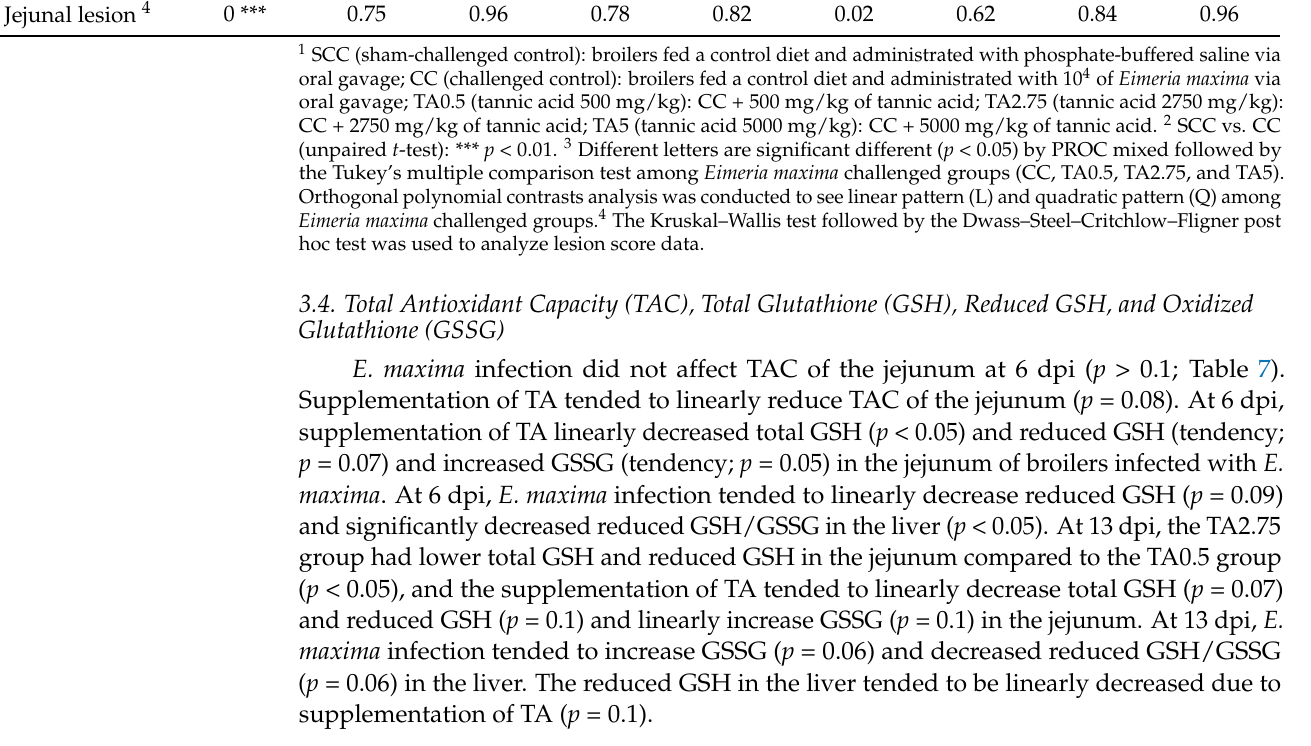
Table 6. Effects of tannic acid supplementation on serum FITC D4 concentration and Eimeria maxima lesion in broiler chickens infected with Eimeria maxima at 5 days post-infection (dpi) and 6 dpi, re- spectively 1 .